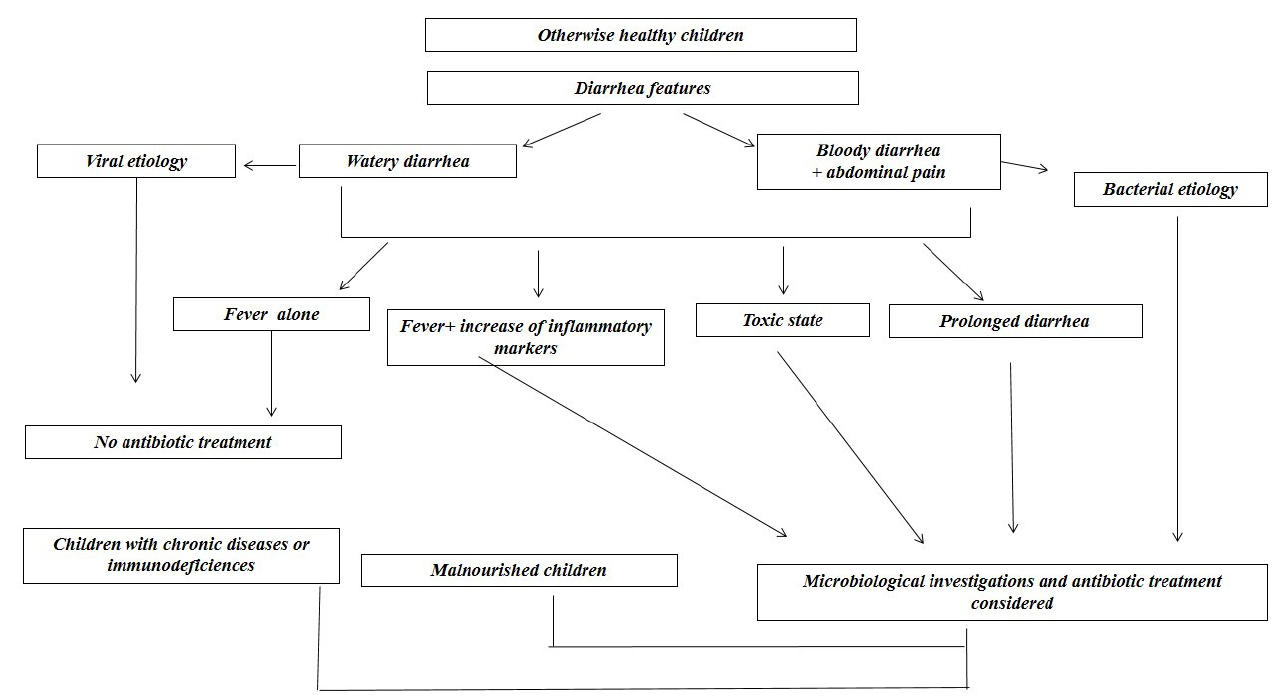
Figure 1. Criteria to decide antibiotic treatment in children with infectious